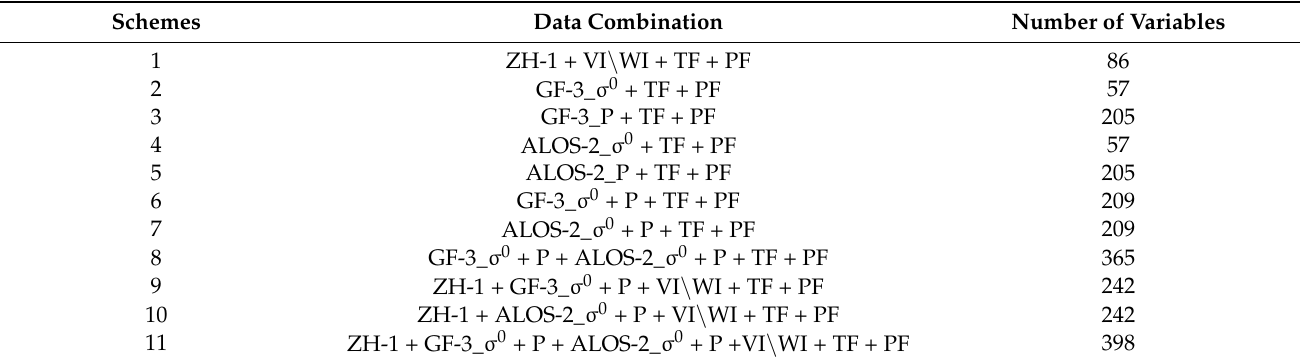
Table 4. Classification Schemes with the combination of different feature variables from multi-sensor images.